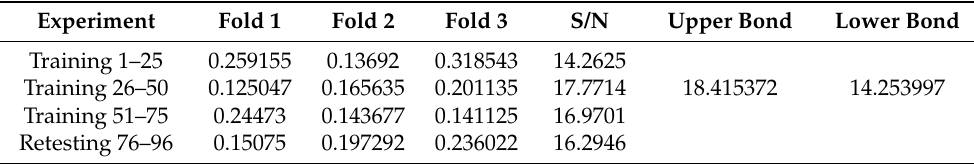
Table 10. The results of experience of optimal parameters.